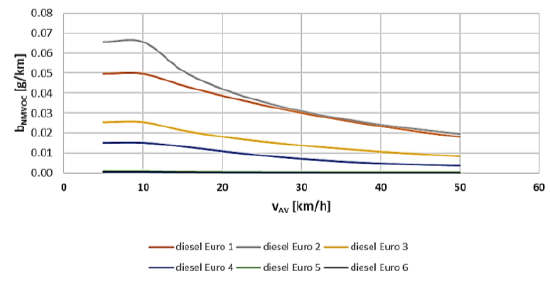
Fig. 21. NMVOC emission from diesel oil PCs for Euro standards depending on average speed